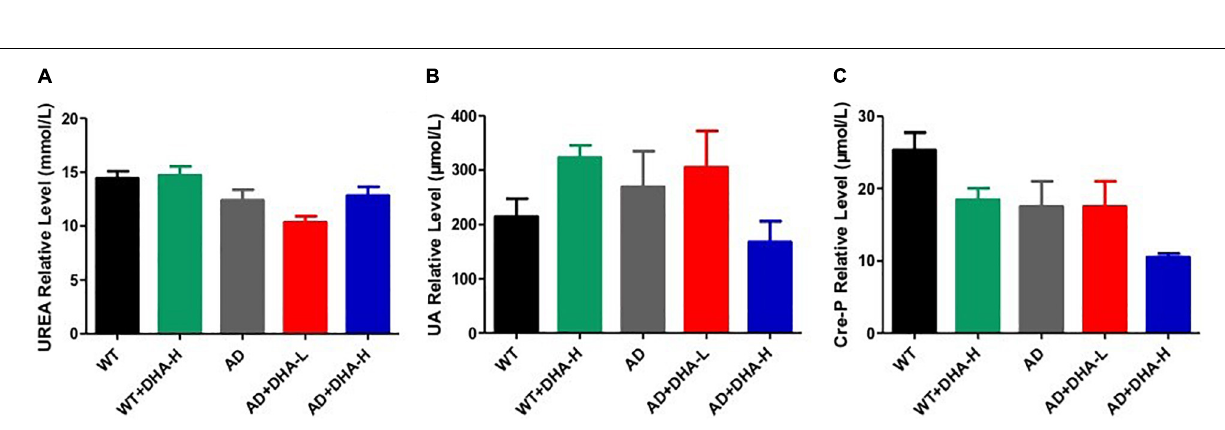
FIGURE 8 | Effect of DHA treatment on kidney- indicators in 2 × Tg AD mice. (A) Urea; (B) auric acid; (C) Cre-P. Student’s t test was used for statistical analyses. Error bars represent mean ± S.E.M. ( n = 6).